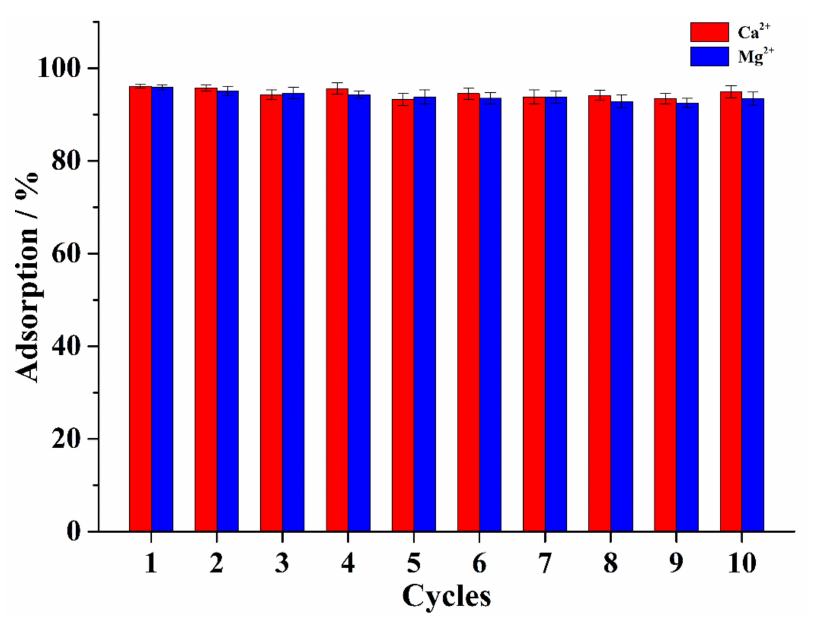
Figure 10. Adsorption/desorption cycle performance of the